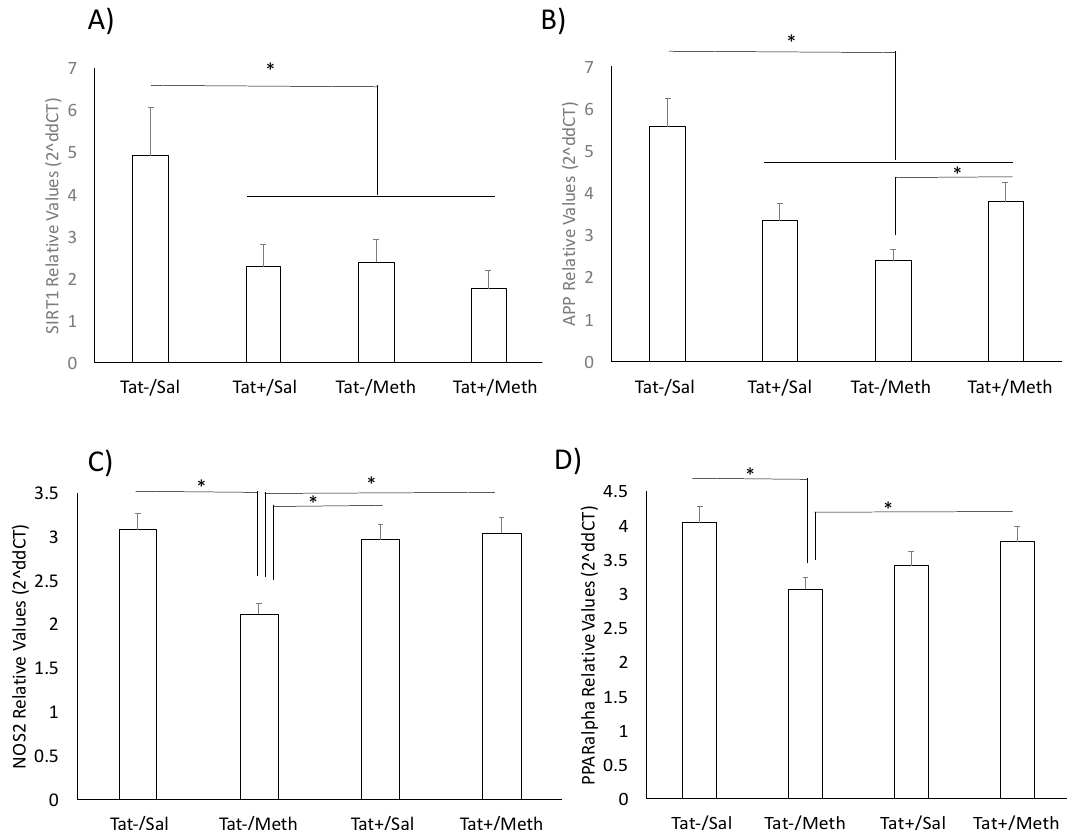
Figure 9. PCR validation of key genes not affected by the interaction between Tat expression and Meth during sensitization. The primers for ( A ) SIRT1; ( B ) amyloid precursor protein (APP); ( C ) NOS2; and ( D ) PPARa were purchased from Qiagen, and the expression was normalized by the average of 2 housekeeping genes, 18S and GAPDH. * p < 0.05 in ANOVA followed by Bonferroni’s post hoc test between assigned comparisons.